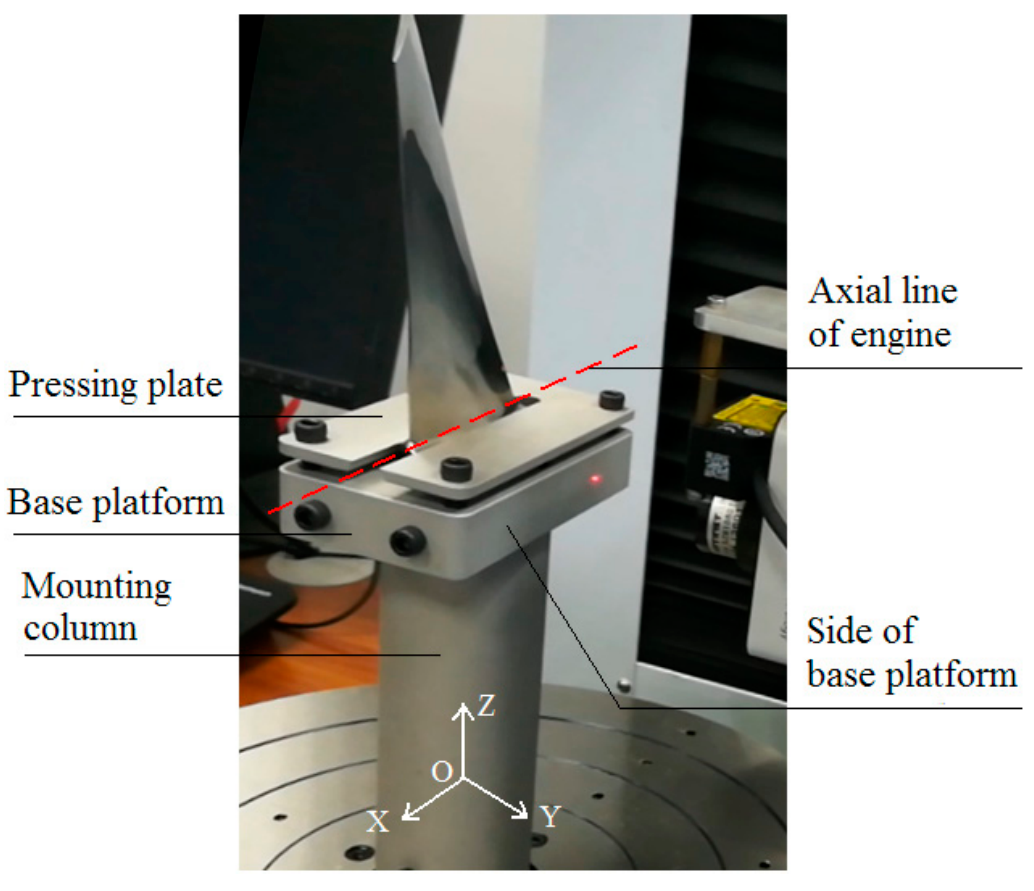
Figure 5. Fixture for blade clamping.